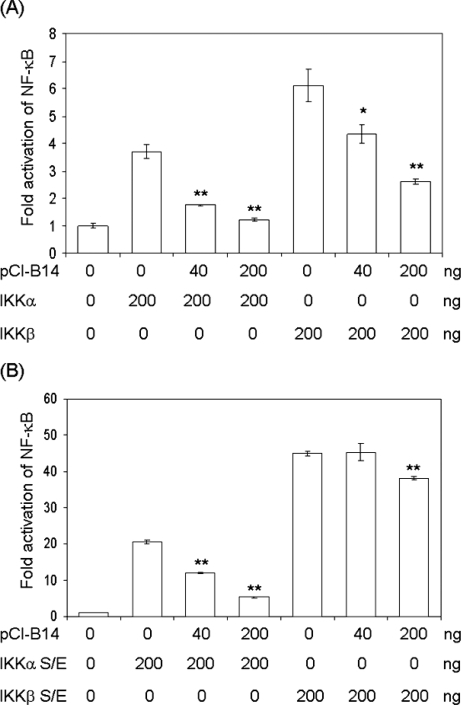
The Effect of B14 on IKKα and IKKβ-Induced NF-κB ActivationHEK 293 cells were co-transfected with reporter plasmids for NF-κB (90 ng), TK-RhL as internal control (10 ng), and the indicated amount of plasmids expressing either wild type IKKα or IKKβ (A), constitutively active IKKα or IKKβ (B), or B14 (A and B). The total amount of DNA applied in each reaction was adjusted to 500 ng using pCI empty vector. After 24 h, the cells were lysed and the activities of both luciferases were measured using Dual-specific luciferase assay kit (Promega) in triplicates. Differences in the fold activation of the NF-κB reporter induced by the indicated IKK subunit in cells transfected with the empty vector and cells expressing B14 were analysed by Student's t-test and the p-values are indicated: * p < 0.05 or ** p < 0.01.